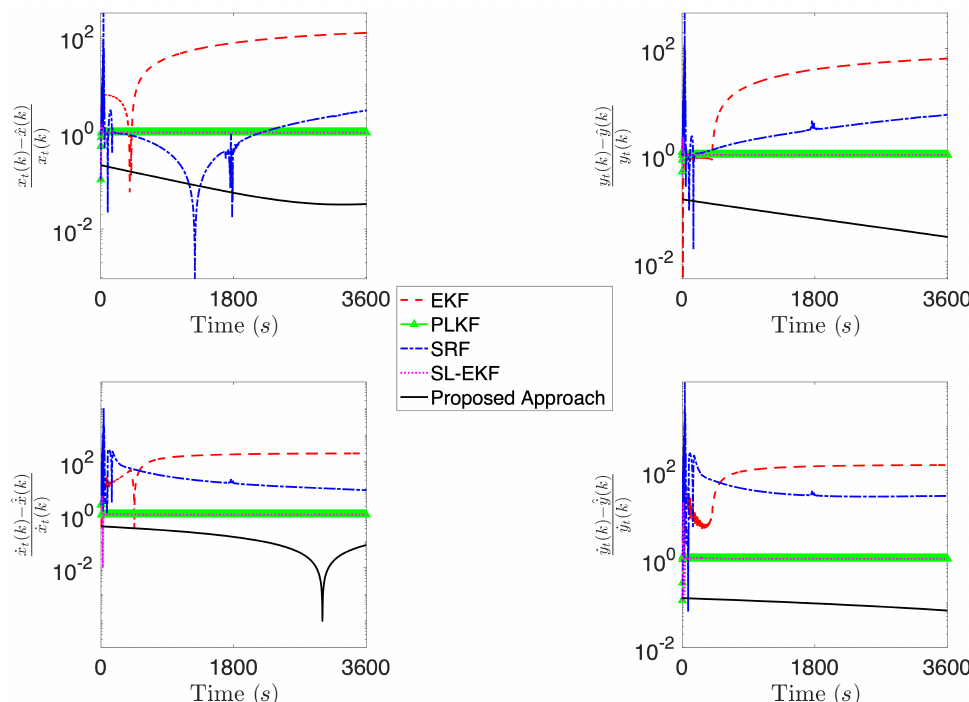
Figure 11. Comparison of the proposed approach against EKF, PLKF, SRF and SL-EKF, con- sidering a scenario where the methods compared with the proposed one are initialized with